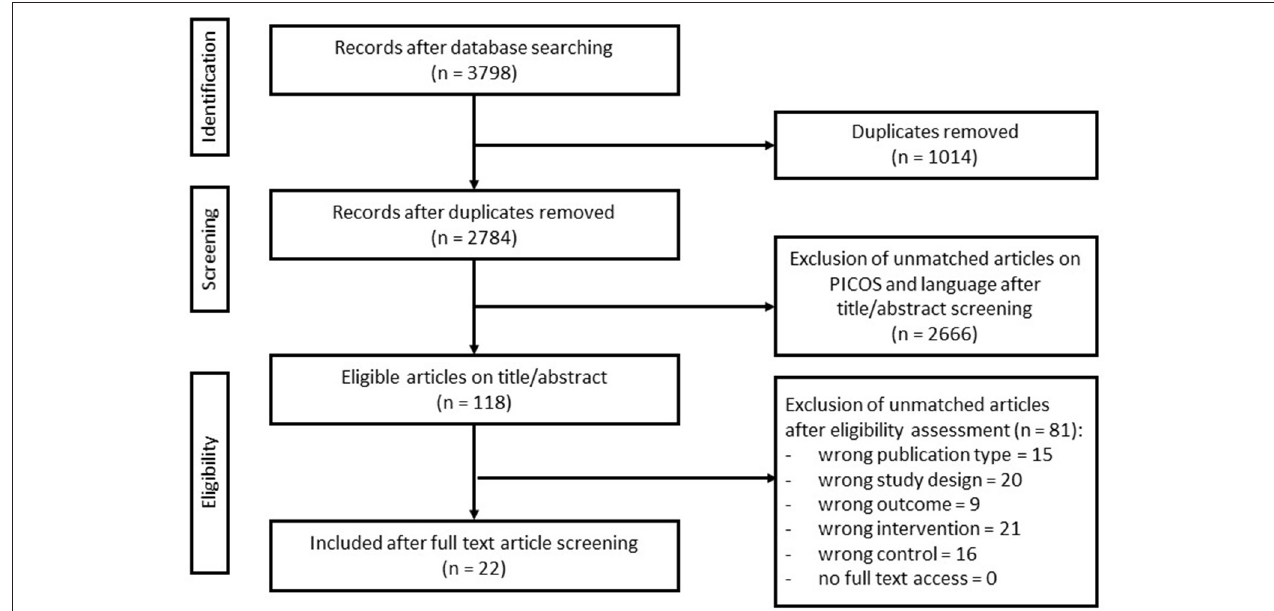
FIGURE 1 | Flow diagram of search and screening methodology. The flow of search results, numbers, and author’s eligibility screening assessment is represented